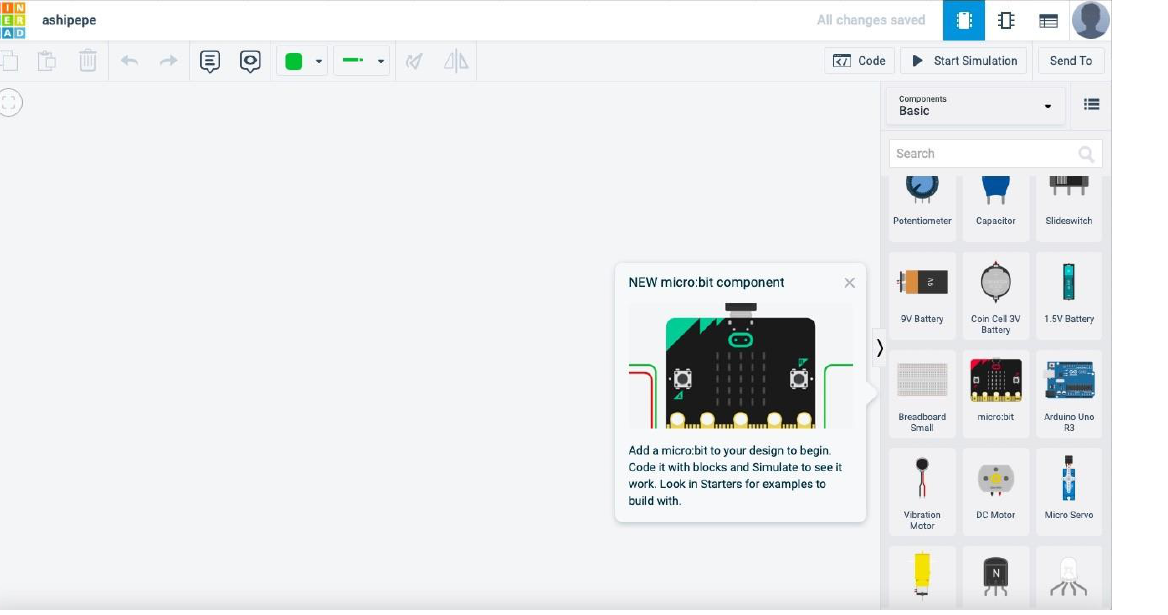
Figure 5. Learners working on Tinkercad.